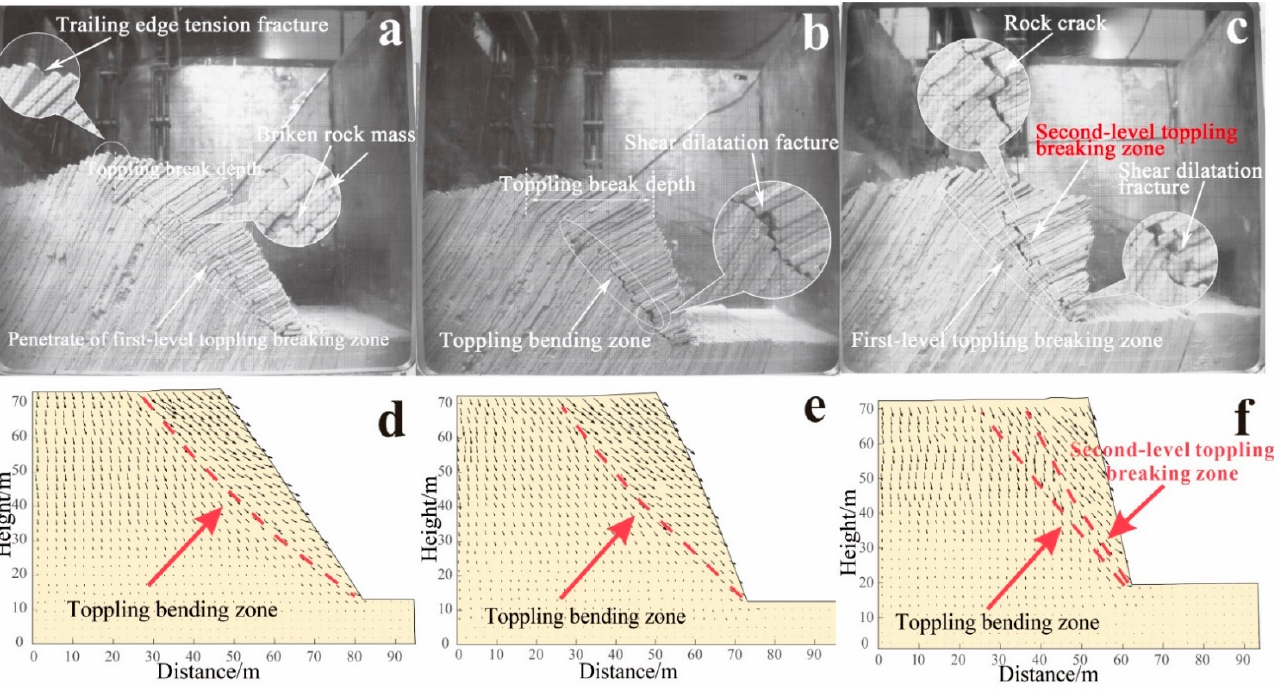
Figure 7. Failure patterns after slope toppling, ( a ) 55° slope toppling, ( b ) 65° slope toppling, ( c ) 75° slope toppling, ( d ) displacement vector diagrams of the 55° slopes, ( e ) displacement vector diagrams of the 65° slopes, ( f ) displacement vector diagrams of the 75° slopes.